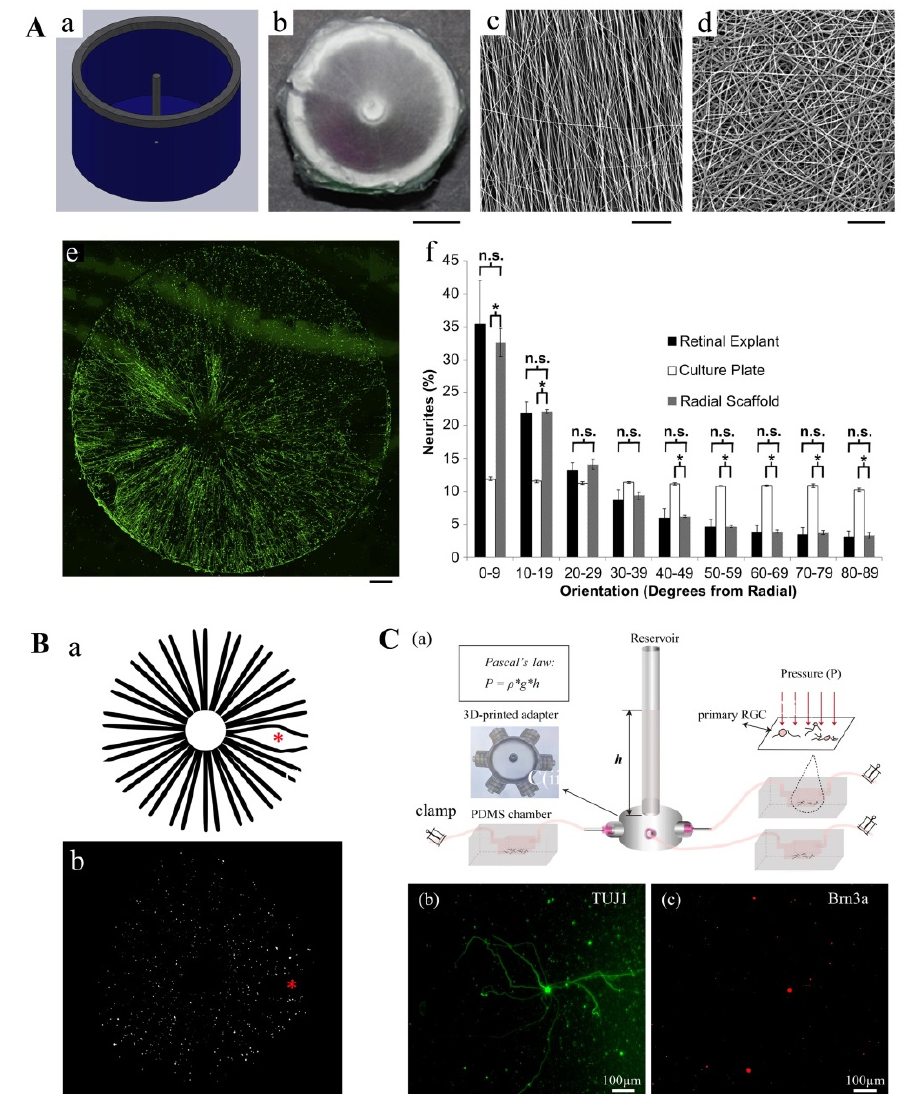
Figure 5. 2D models of retina ganglion cell. ( A ) RGCs cultured on radial electrospun scaffolds mimic the axonal orientation of retina. Production and optimization of the radial electrospun scaffold. ( a ) Diagram of a 1.8-cm diameter radial collector containing a conducting central pole and rim grounded to the same source; ( b ) top view of an electrospun radial scaffold; ( c , d ) SEM image of peripheral radial fiber zone ( c ) and central random fiber zone ( d ); ( e ) fluorescence image of RGCs on radial scaffolds prohibited 81.1% ± 2.8 alignment of neurites in radial orientation. Green: β 3-tubulin; ( f ) orientation analysis of RGC neurites on different scaffolds. No significant difference was observed between retinal explants and radial scaffold. Scale bars: b: 5 mm, c: 50 μ m, d: 100 μ m, e: 1 mm [147]; ( B ) thermal-inkjet 3D cell printing techniques can mimic the in vivo RGC distribution on retina. ( a ) estimated RGC distribution on retina, including higher cell density near the optic nerve head and lower density at the fovea (*); ( b ) RGC distribution results by inkjet 3D printing; scale bar: 550 μ m [148]; (C) apparatus applying adjustable hydrostatic pressure to primary RGCs based on Pascal’s law. ( a ) diagram of the apparatus, a transparent reservoir connecting with multiple PDMS chambers, which are containing primary RGC cultures; ( b , c ) representative fluorescence images of primary RGCs cultured inside a PDMS chamber at day 3 in vitro. RGCs were positively stained with TUJ1 (green) and BRN3A (Red), which are neuronal-specific and RGC-specific, respectively [149]. Figure republished with permission from each indicated reference ([147] for part A, [148] for part B, [149] for part C).